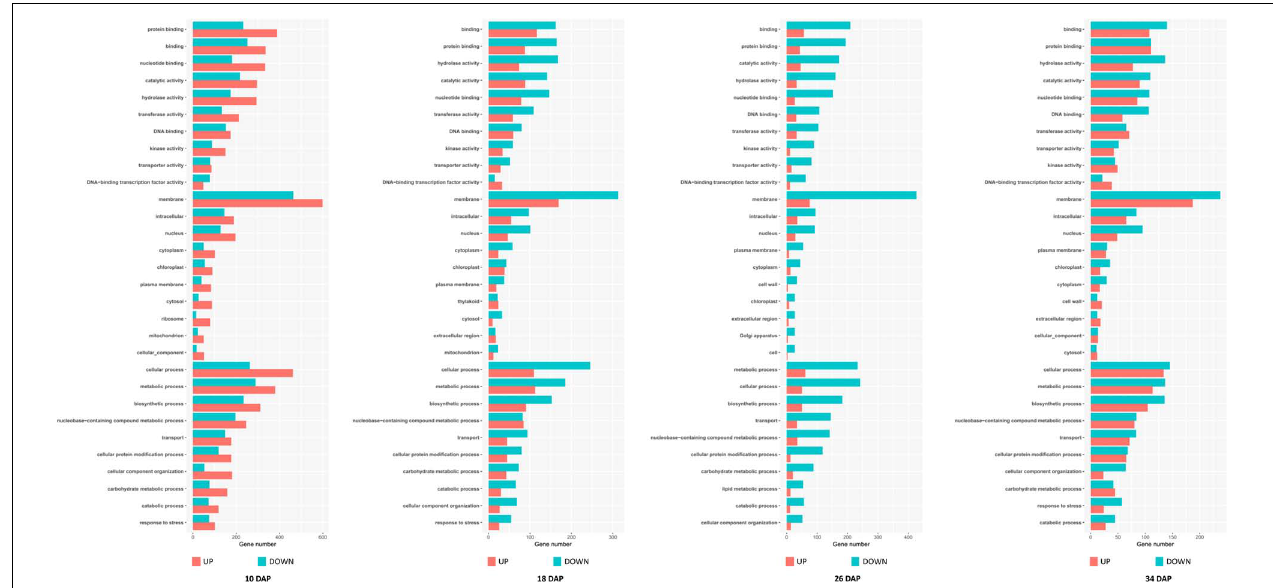
FIGURE 5 | Gene Ontology (GO) terms enrichment of the differentially expressed genes in self-grafted (SG) watermelon plant and pumpkin-grafted (PG) watermelon